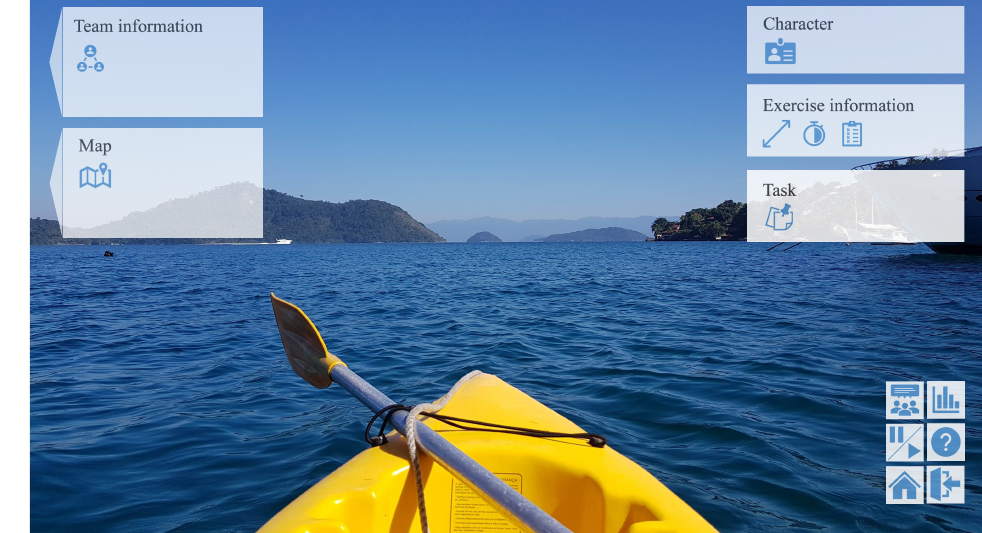
Figure 4. A concept user interface design of VRrowing